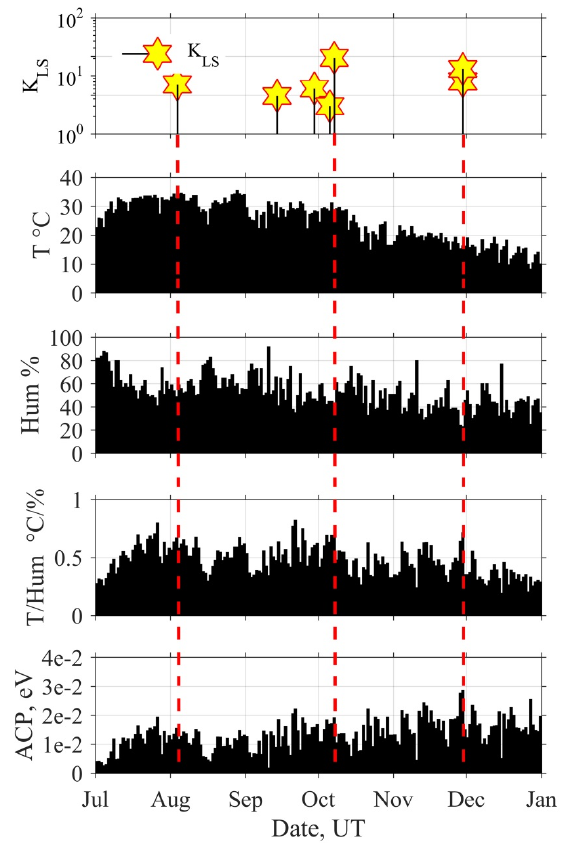
Figure 4. The top panel displays the evolution of seismicity K LS for Tokyo; Mishima station. 2nd and 3rd panels show the evolution of maximum daily air temperature and minimum daily humidity, and the corresponding evolutions of T/Hum and ACP are depicted on bottom two panels. Table 1. The parameters of the EQs shown on the map in Figure